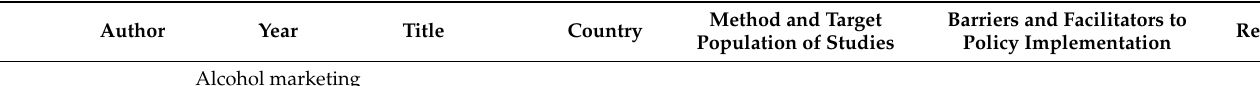
Figure 1. Article screening process. Table 1. Barriers and facilitators to policy implementation among the four